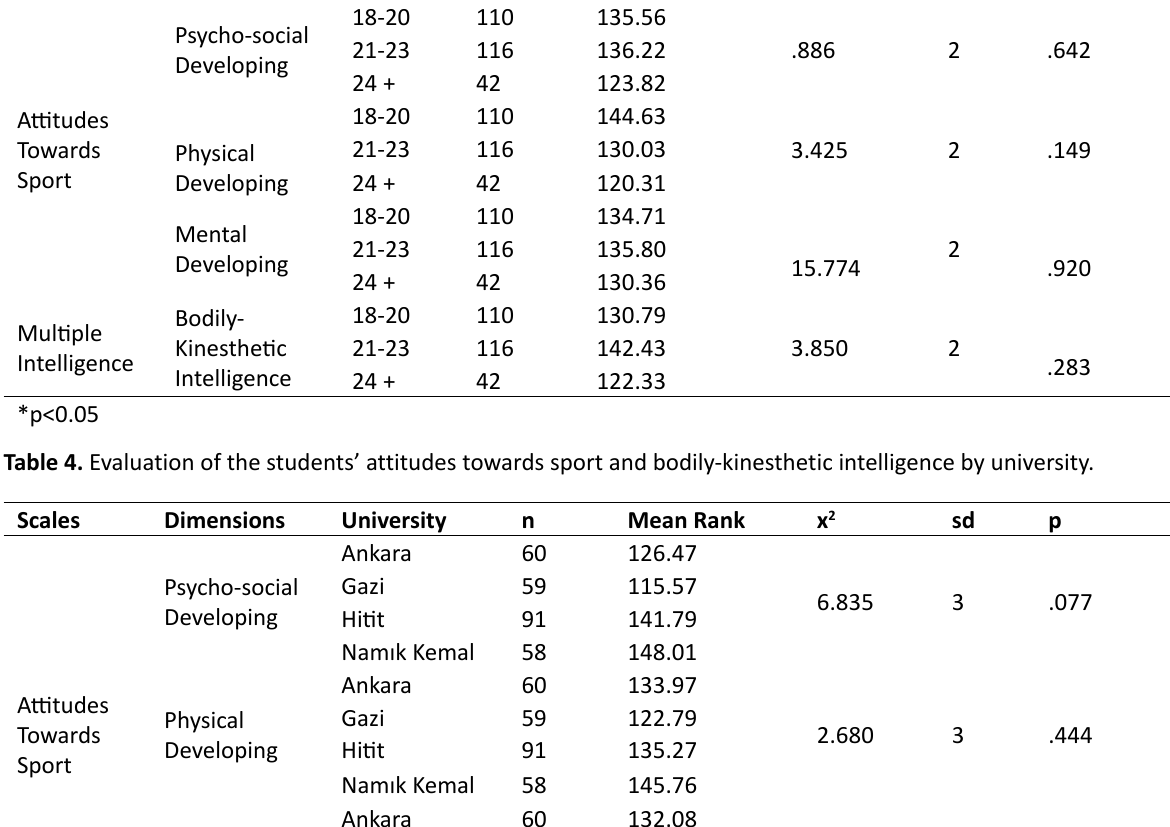
Table 3. Evaluation of the students’ attitudes towards sport and bodily-kinesthetic intelligence by age. Scales